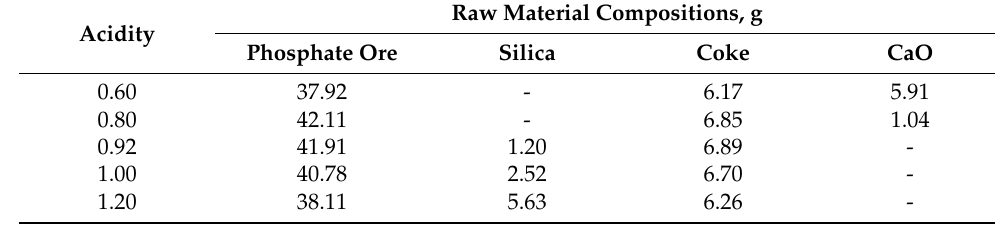
Table 3. Design of raw material compositions under different ternary acidity conditions.